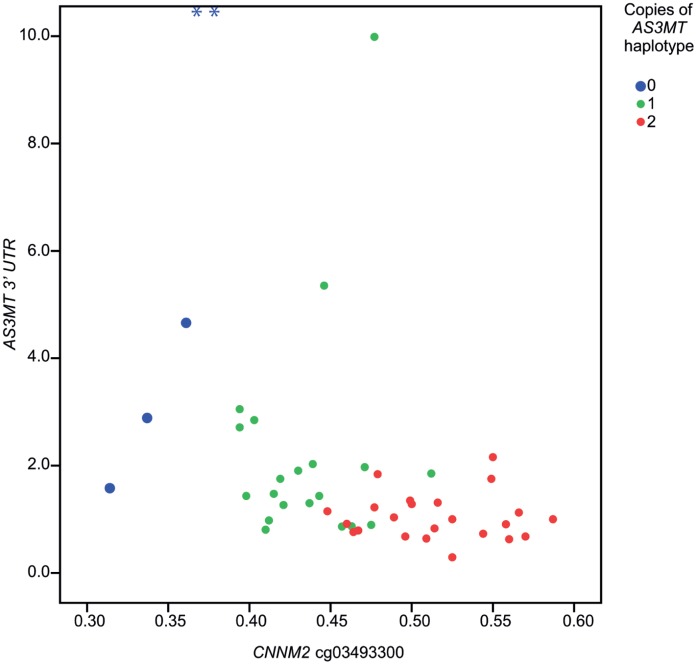
The relationship between CNNM2 DNA methylation and AS3MT gene expression, stratified for AS3MT haplotype.Scatterplot depicting the relationship between DNA methylation (expressed as fraction of methylated CpG) for CNNM2 (X-axis) and gene expression for AS3MT (3′UTR; expression relative to the median for individuals with 2 copies of the AS3MT haplotype) (Y-axis), where individuals are stratified for AS3MT haplotype (total N  = 48). Outliers are denoted by *; the outlier to the left has a relative gene expression of 22.8 and the outlier to the right has a relative gene expression of 24.9.